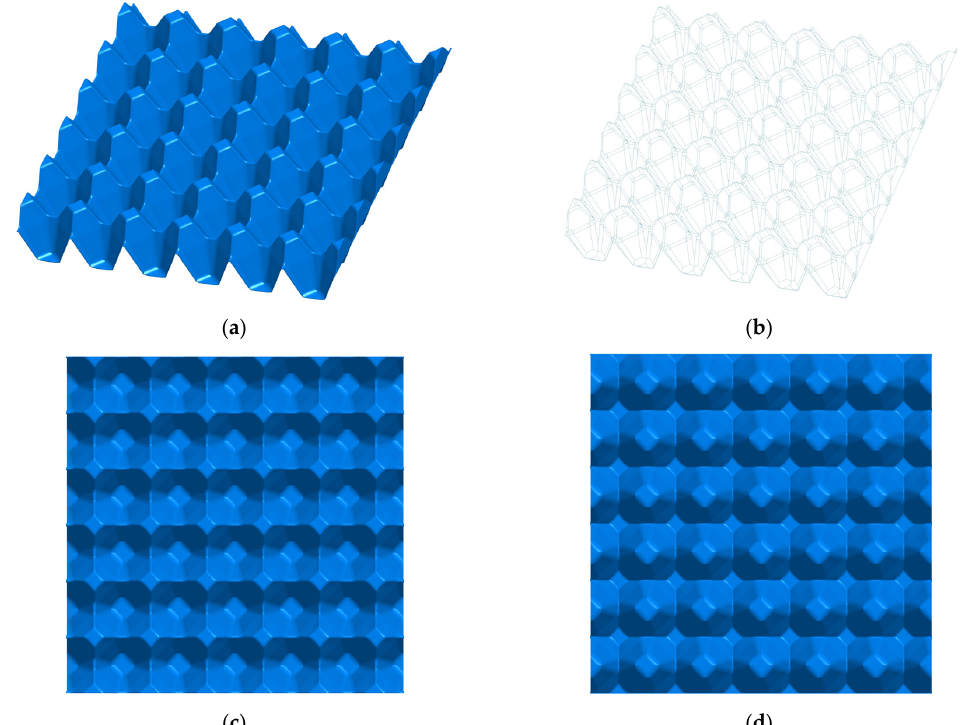
Figure 1. A 3-dimensional model of a basic tray ( a – b ), view from the top ( c ), and view from the bottom ( d ).